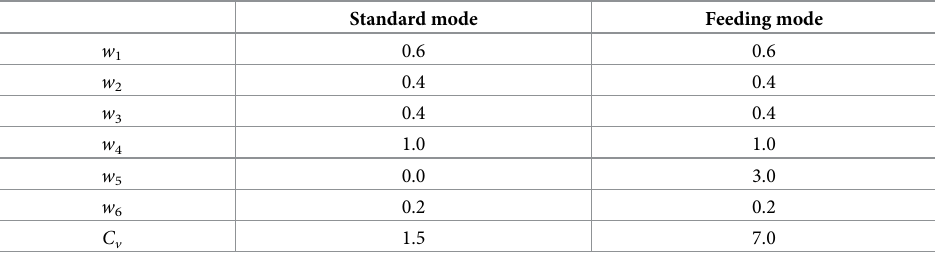
Table 2. Weight coefficient, w n , of each force vector and coefficient of maximum velocity for each swimming